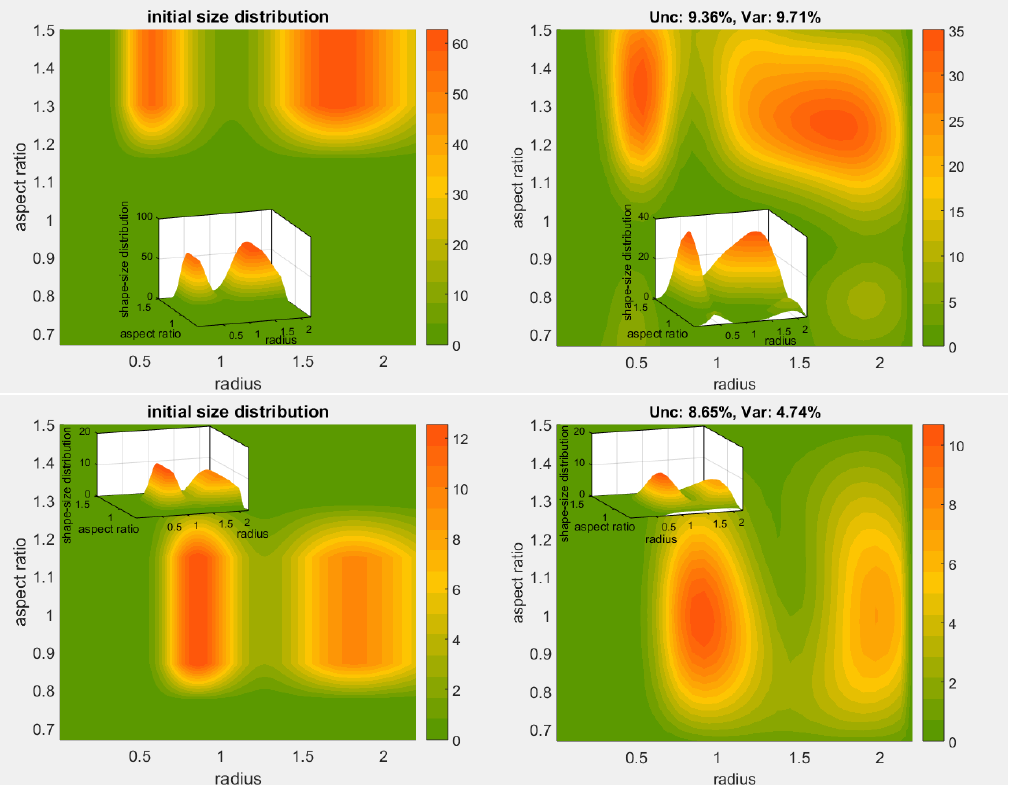
Figure 6. Reconstructions of bimodal shape-size distributions with two distinct radius-modes. Top down, right: reconstructions corresponding to the BMD 1–4 from Table 3. Left: Initial shape-size distributions for the reconstructions on the right. Smaller plots within the main plots show the shape-size distribution in 3D.